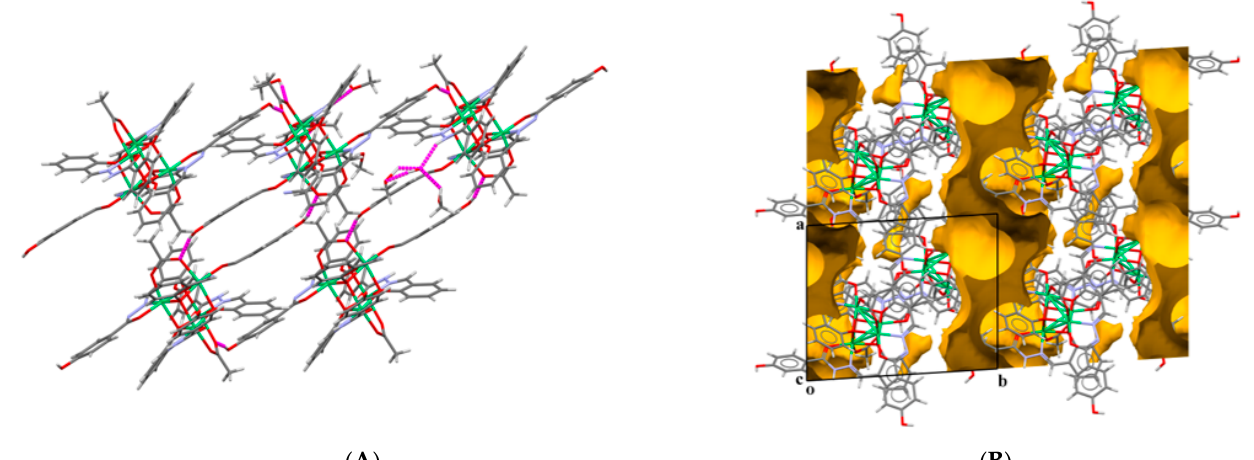
Figure 5. ( A ) Crystal packing view of 3 ∙ 4MeOH ∙ 0.63H 2 O ∙ 0.5MeCN ∙ HOAc showing O–H ∙∙∙ O and N–H ∙∙∙ O intermolecular hydrogen bonds by magenta dashed lines. ( B ) The existence of two types of voids (denoted in yellow) is obvious; one in the form of channels that accommodates non-disordered solvent molecules and the other that are discrete, accommodating disordered solvent molecules. Color code: Ni-green, N-blue, O-red, C-gray, H-white.